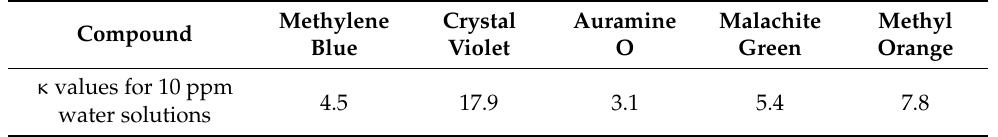
Table 1. Computed κ values for 10 ppm water solutions of industrial dyes penetrated by a monochro- matic radiation wavelength λ = 254 nm, corresponding to high-pressure mercury lamp maximum spectra. The height of the optical layer δ is equal to 5 cm. Methylene Crystal Auramine Malachite Methyl Compound Blue Violet O Green Orange κ values for 10